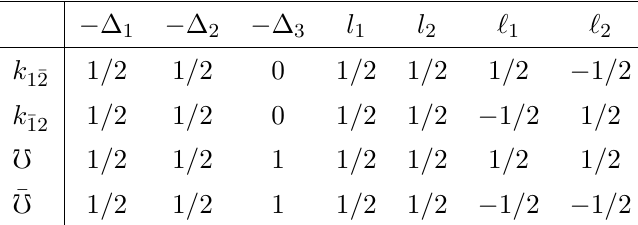
Table 2. Degrees of additional tensor structures of the MST 2 -MST 2 -scalar 3-point function in d = 4 .